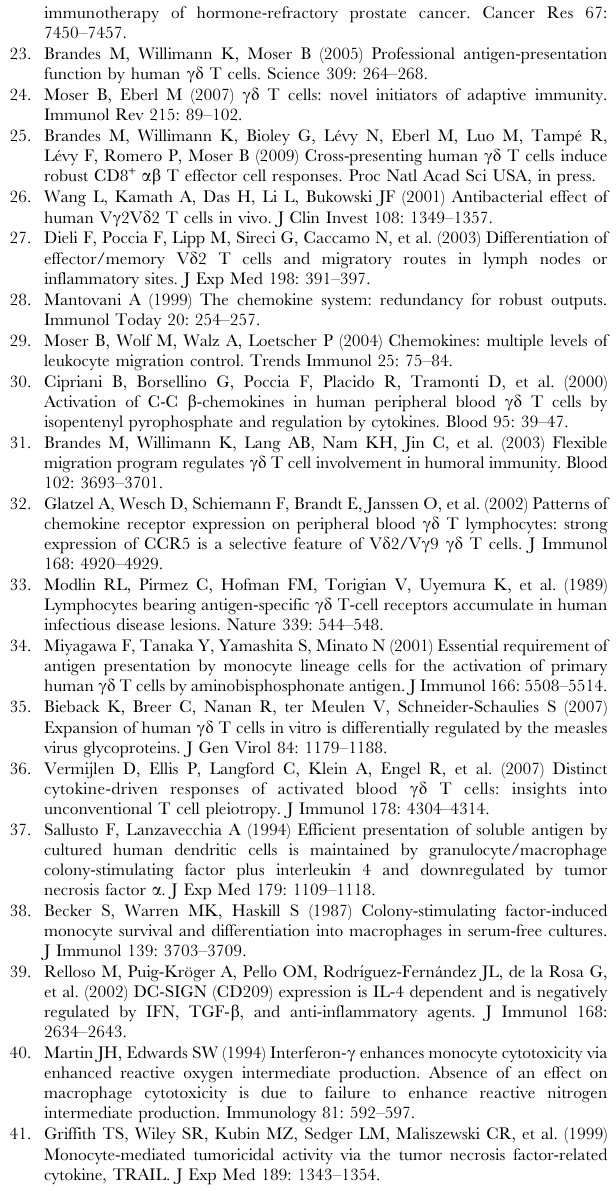
indicate the percentage of CD209 + monocytes. ( B ) MFI 6 SEM of CD83, CD206, and CD209 for monocytes after 18 hours of culture under the conditions indicated ( n = 4–10). Figure S5 Peritoneal cd T cells respond to HMB-PP and promote monocytes differentiation. 250,000 peritoneal cells were cultured with HMB-PP at the indicated concentrations. ( A ) Microscopic analysis of cultures after 18 hours in the absence or presence of 100 nM HMB-PP and the blocking reagents indicated. ( B ) cd T cell responses are shown as % of V c 9 + T cells expressing surface CD25 and CD69, and intracellular TNF- a , and as % of V c 9 + among all CD3 + T cells after 7 days. ( C ) Monocyte responses are shown as forward scatter; MFI of CD14, CD40, CD86, and TRAIL; and percentage of TNF- a + monocytes after 18